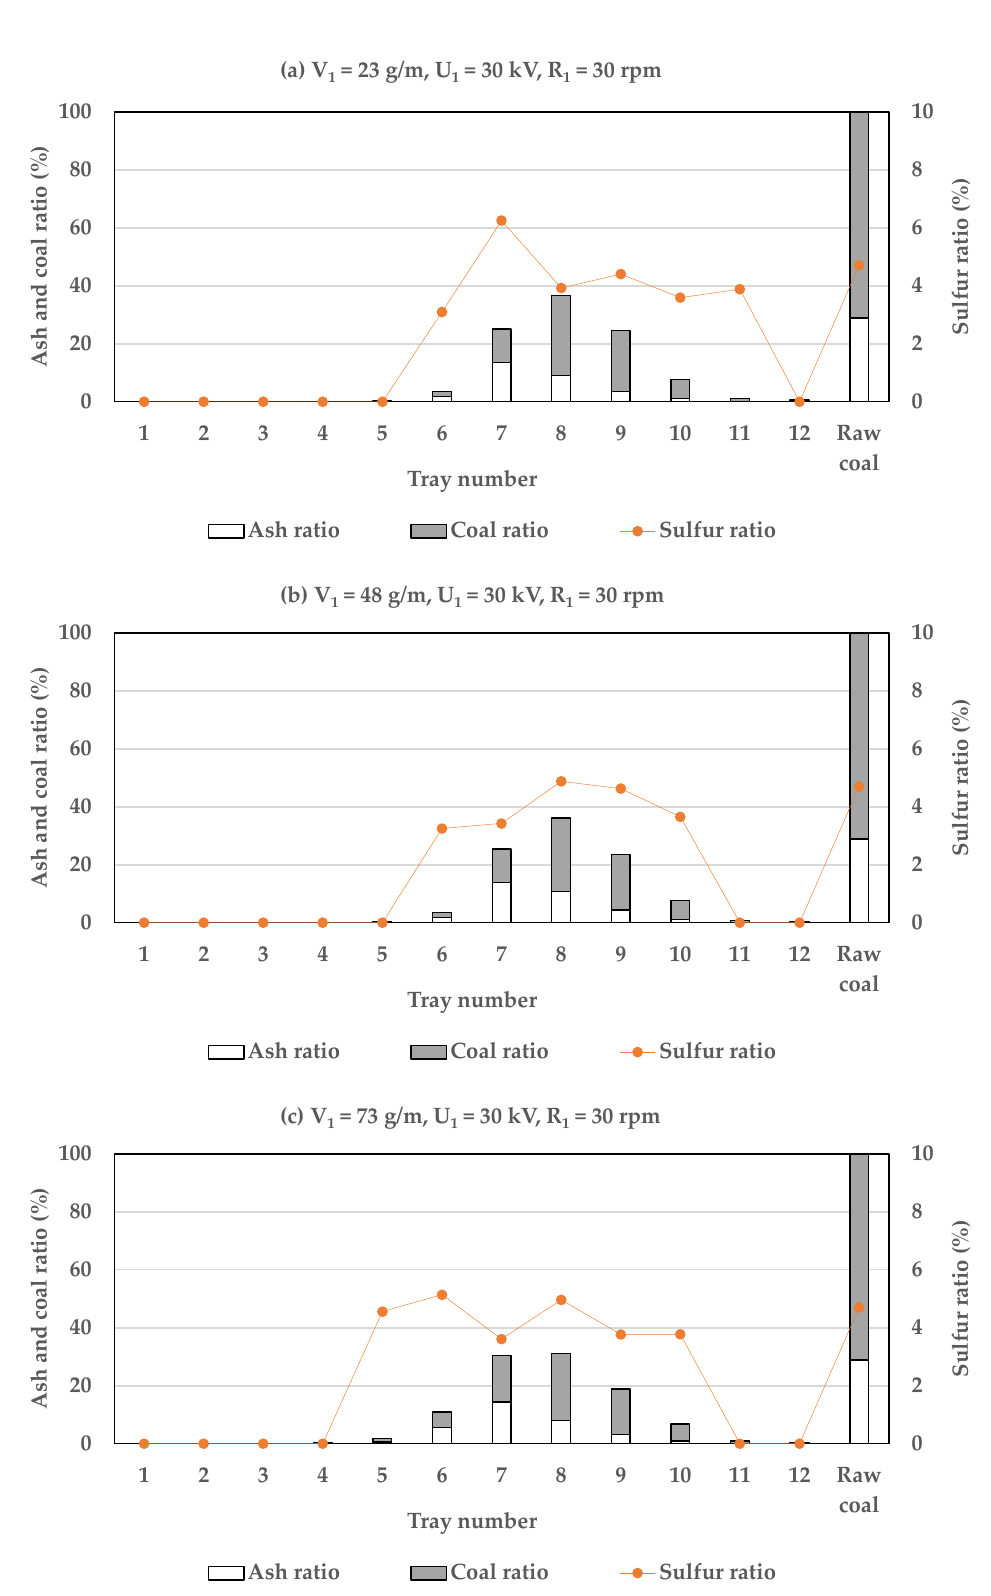
Figure 7. Ash ratio (%), coal ratio (%), and sulfur ratio (%) of the particles collected from the 12 trays at different conveyor speeds: ( a ) 23 g/min; ( b ) 48 g/min; ( c ) 73 g/min using a dry coal cleaning system with two-stage corona electrostatic pro- cesses.